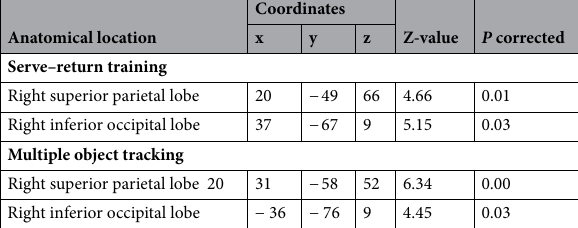
Table 2. Differences in FA between the individuals high VR suitability and low VR suitability for each experiment. The coordinates (x, y, z) indicate local maxima in each brain region according to the MNI